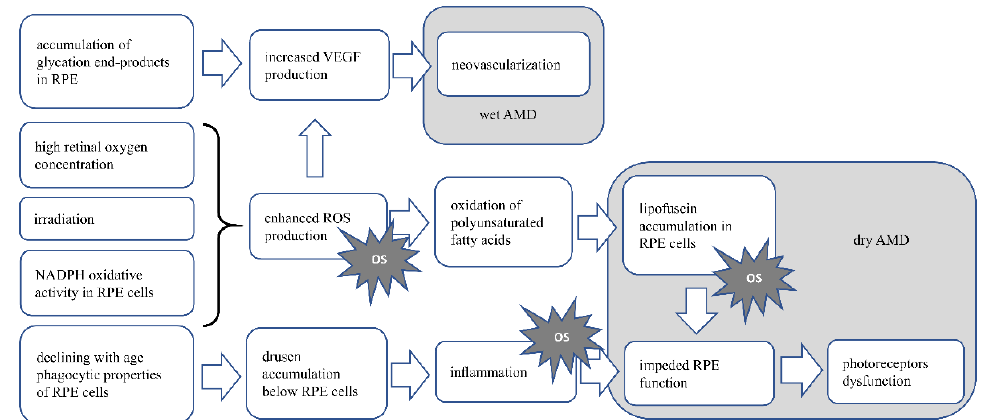
Figure 1. Presents the AMD pathomechanism and oxidative stress